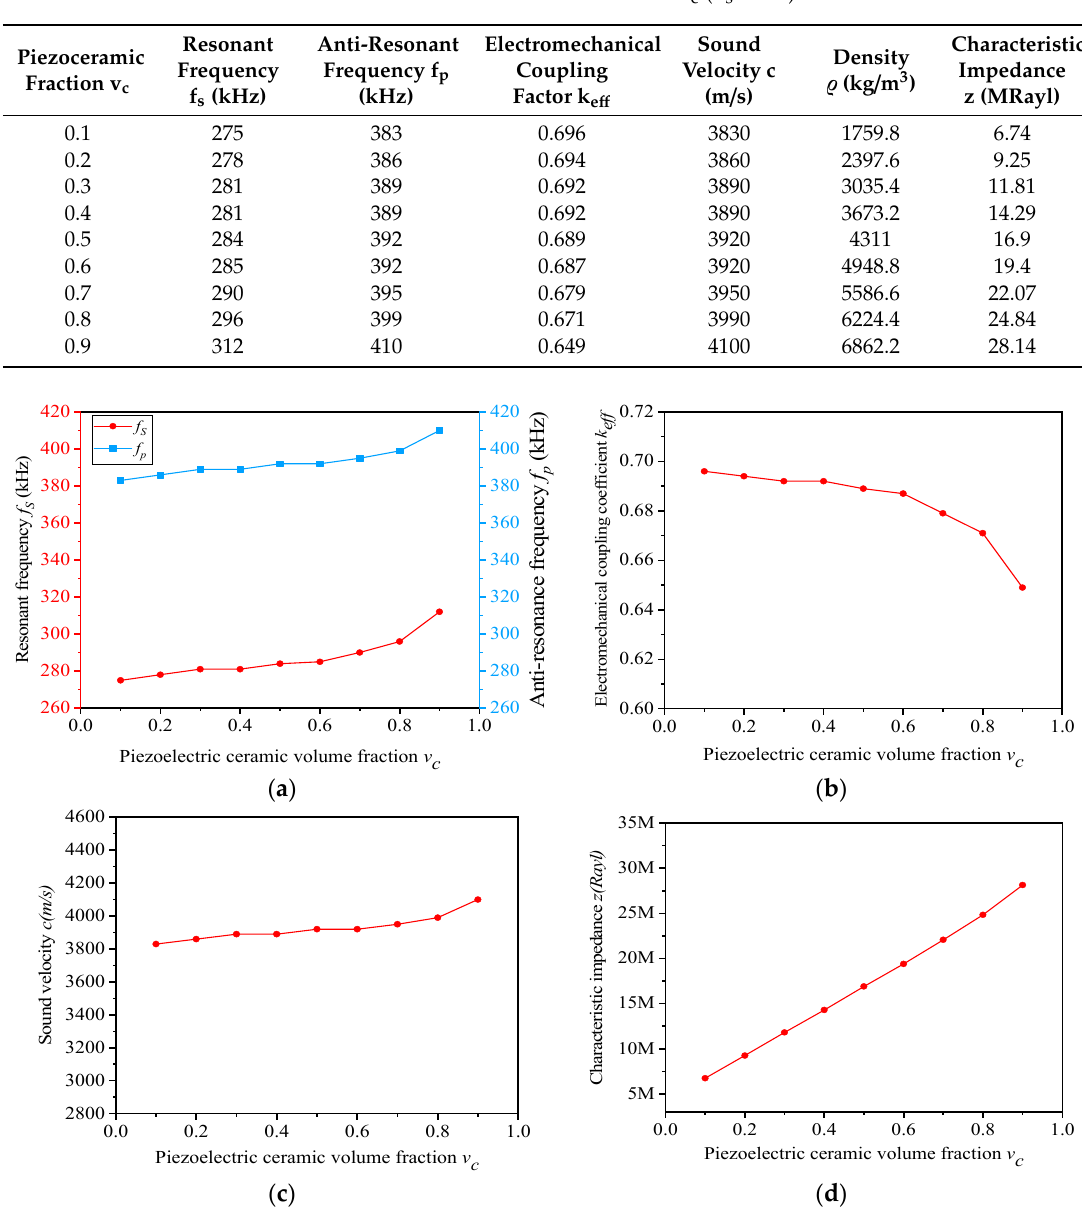
Table 4. Simulation data with di ff erent v c (v s = 0.6).